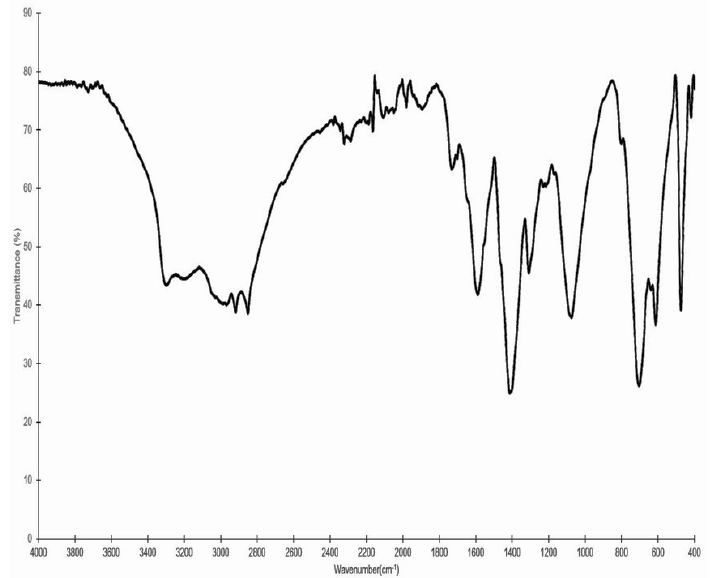
Figure 1. Infrared spectrum of fraction F7, which showed the highest activity in the DPPH, ABTS, and FRAP antioxidant assays.